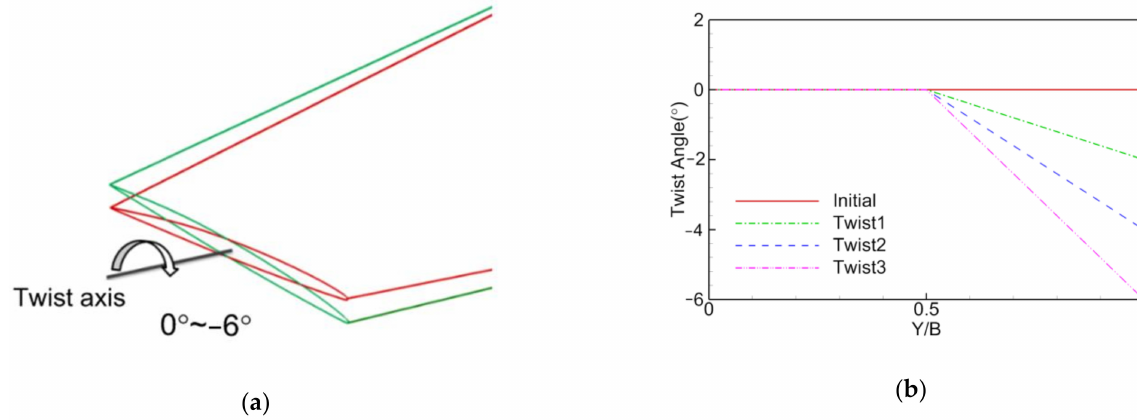
Figure 12. Wing twist: ( a ) Wing twist method; ( b ) Twist distribution in spanwise direction.